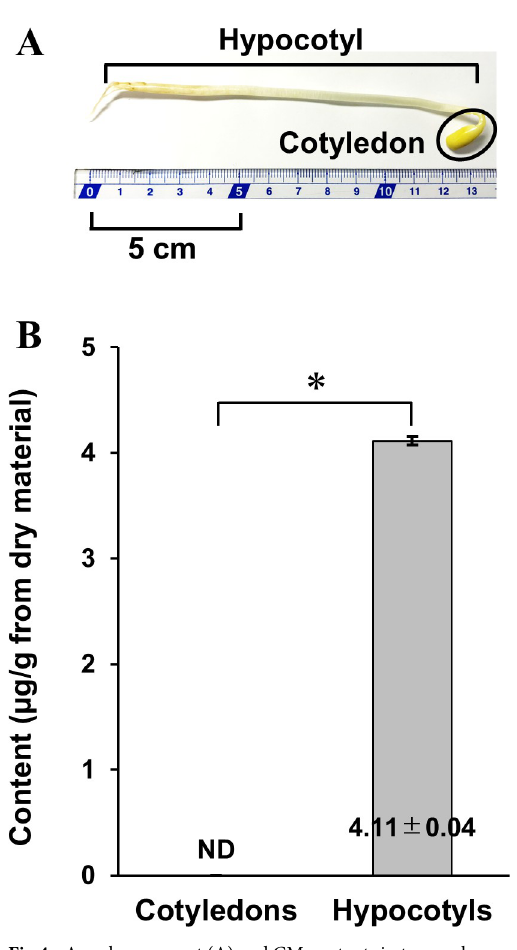
Fig 4. A soybean sprout (A) and CM contents in two soybean sprout organs, cotyledons and hypocotyls (B). The data were analyzed by Student’s t-test, and p < 0.001 ( � ) was considered statistically significant. Values are presented as mean ± SD ( n = 3). ND, not